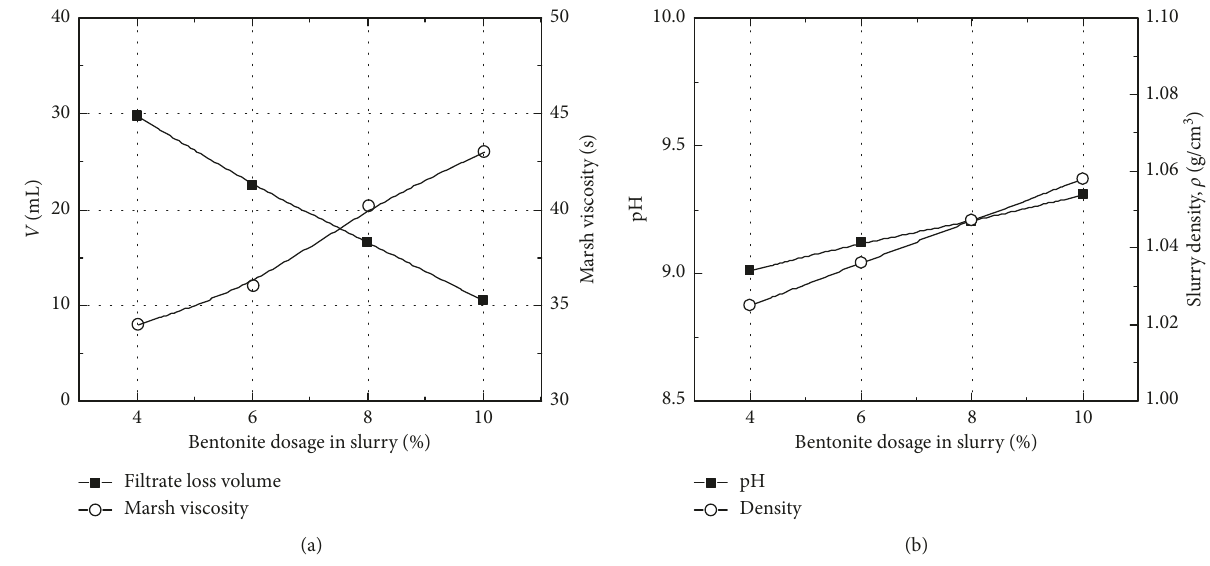
Figure 1: The rheological properties of bentonite-water